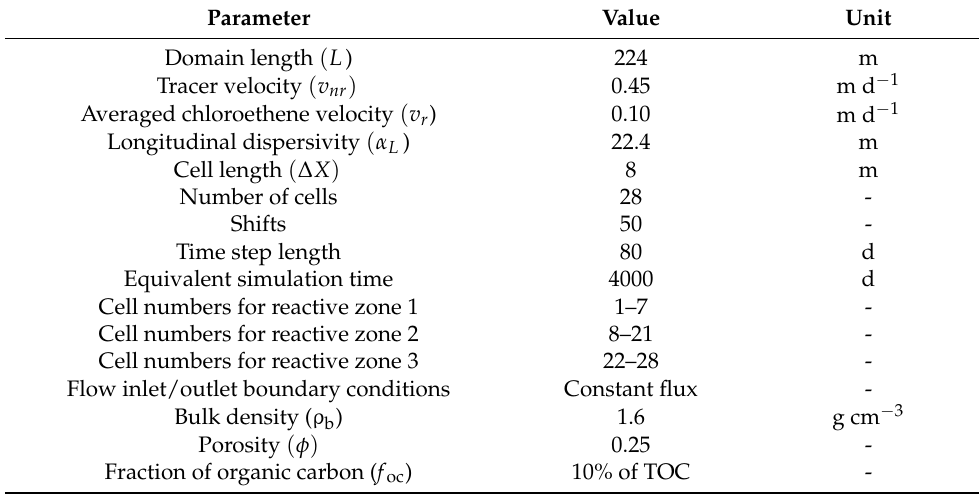
Table 2. PHREEQC model input parameters. TOC: total organic